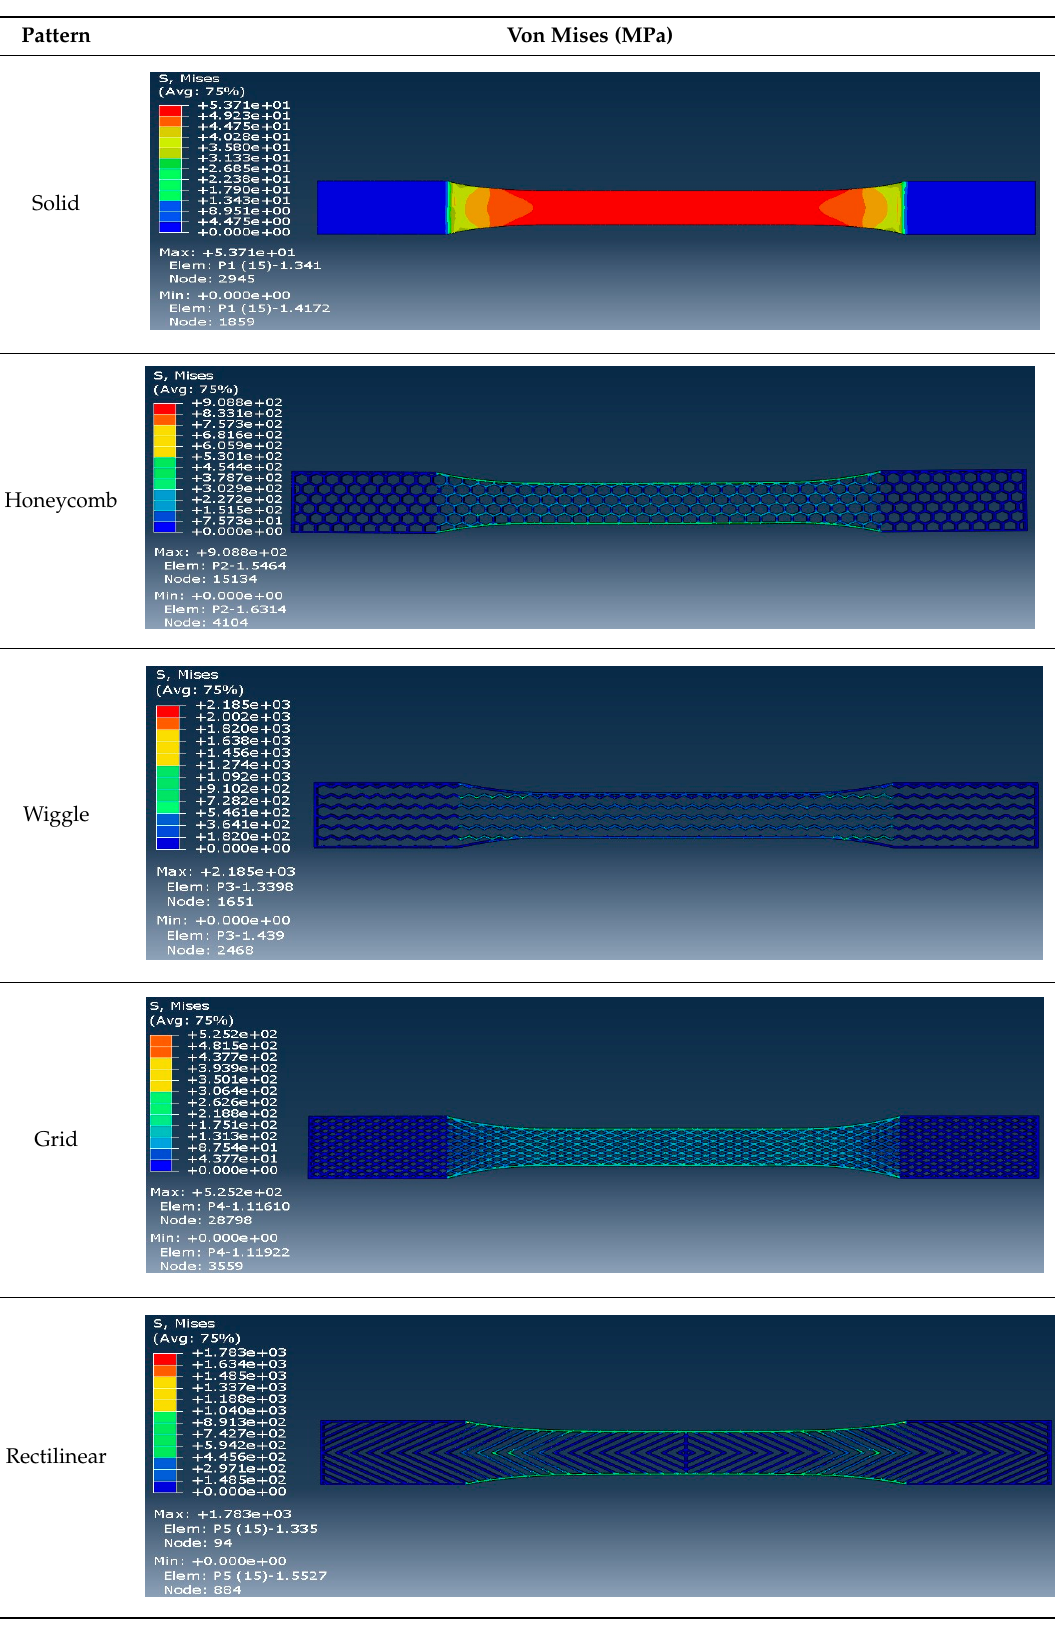
Table 4. Schematic of Von Mises value and stress.